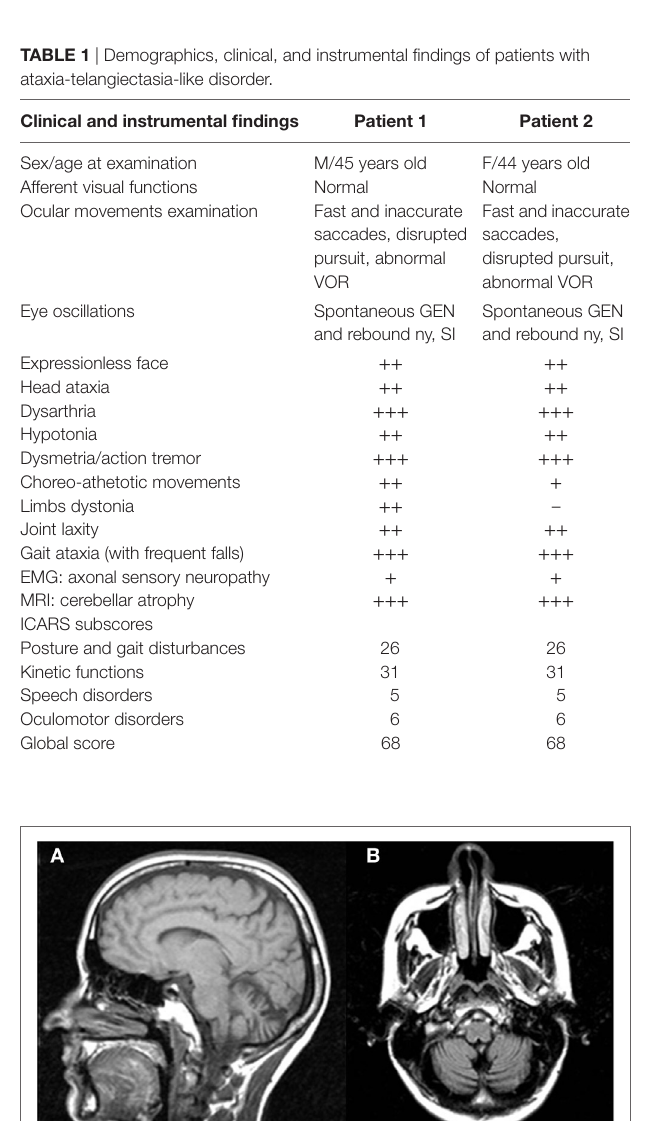
jumps (means for controls, 10°: 10.3 ± 1.1°; 18°: 18.1 ± 1.7°). The mean amplitude for 10° target jumps to the right was instead 11.1 ± 3.6° and 16.5 ± 4.0° for the 18° target jumps (means for controls, 10°: 10.1 ± 1.1°; 18°: 18.1 ± 1.6°). LW and rightward (RW) saccade amplitudes were significantly different (LW 10°: P < 0.001; 18°: P < 0.001; RW 10°: P < 0.05; 18°: P < 0.001) in our patients compared with controls. An example of very large LW hypermetric saccades, typically followed by corrective saccades to reach the target, is illustrated in Figure 2A